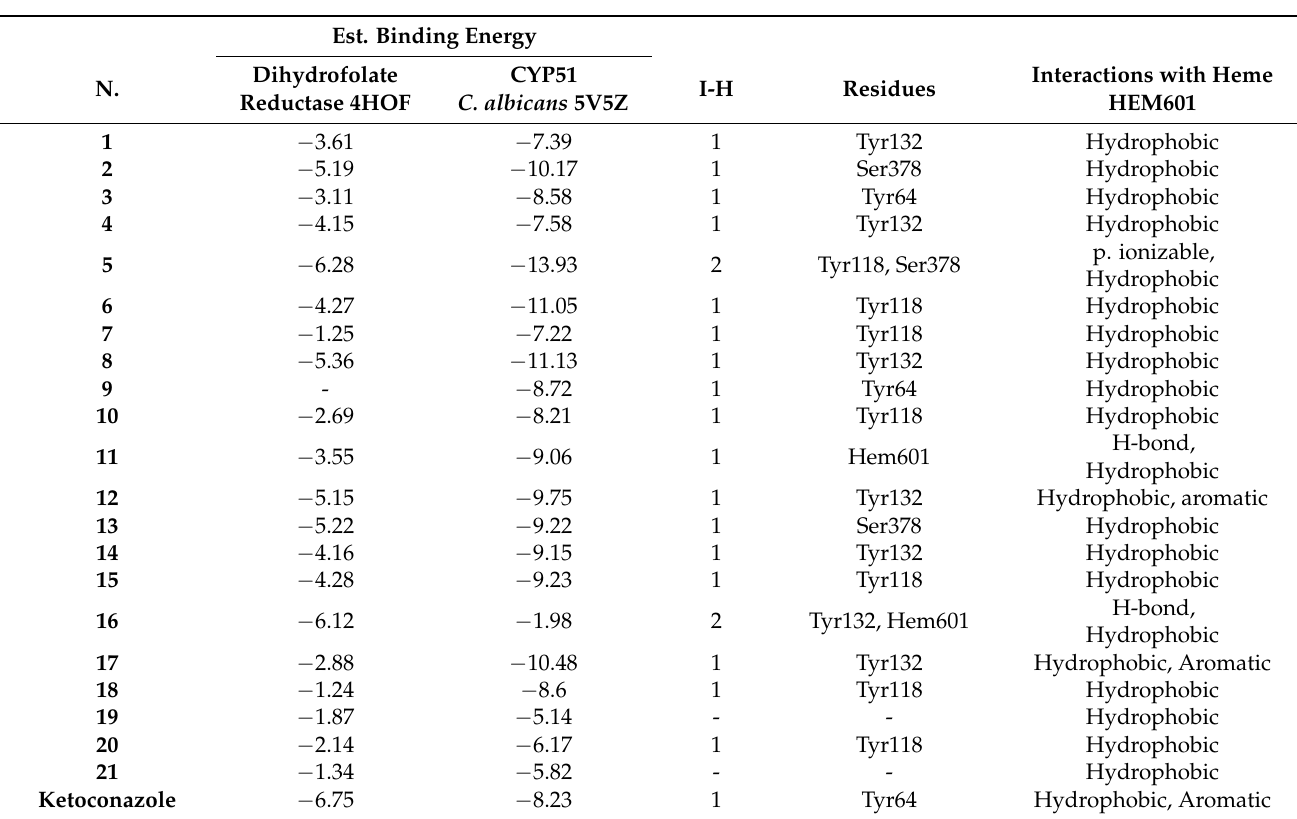
Table 7. Results of docking study on the enzymes dihydrophylate reductase (DHFR, PDB ID: 4HOF) and 14 α -demethylase of lanosterol (CYP51, PDB ID: 5V5Z) of Candida albicans